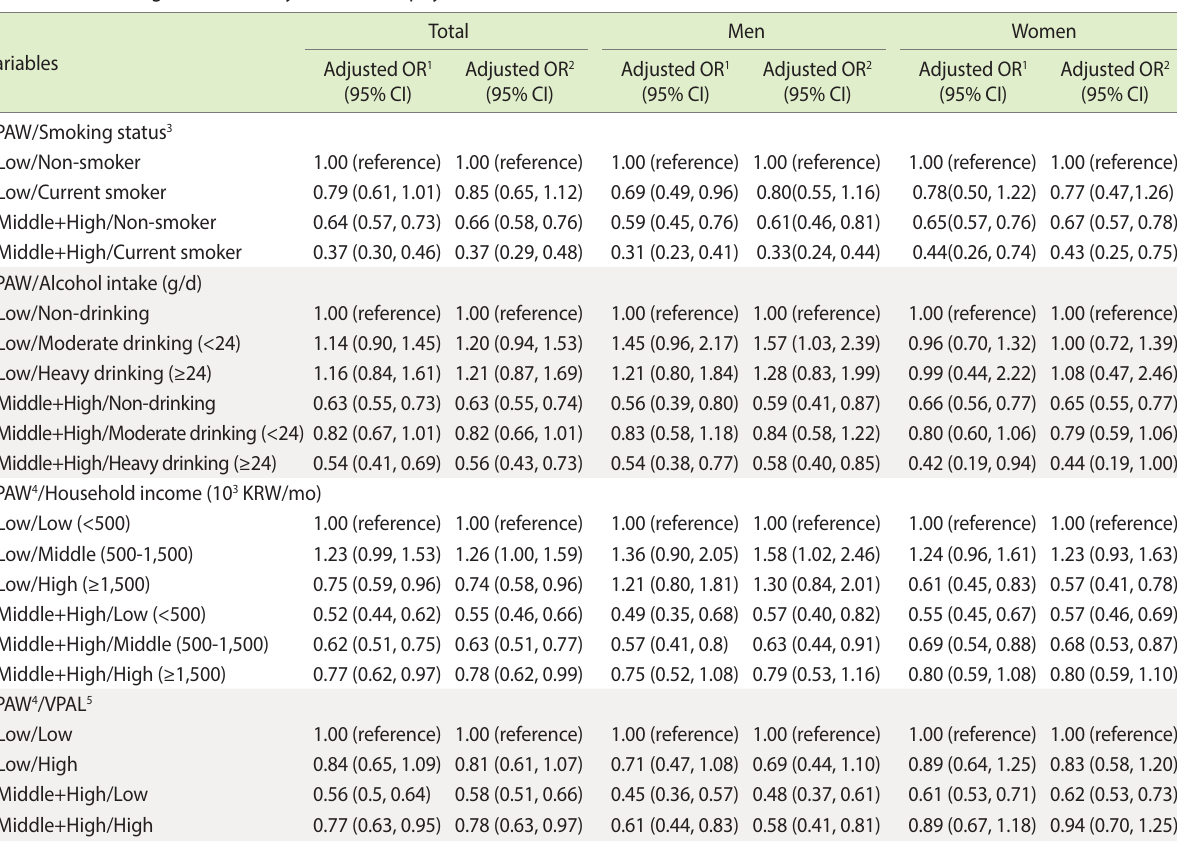
Table 3. Adjusted ORs and 95% CIs of obesity (BMI>25 kg/m 2 ) according to the combination of VPAW with smoking, alcohol intake,